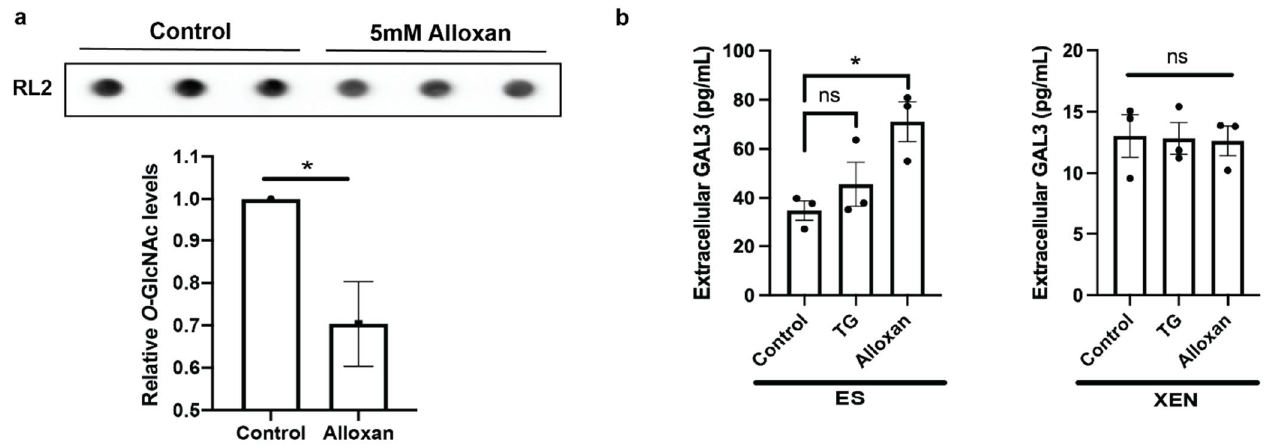
Figure 5. OGT inhibition in ES cells increases extracellular galectin-3. ( a ) Immunodot blot of O - GlcNAc detecting antibody RL2 in ES cells treated with 5 mM alloxan, an OGT inhibitor, and densitometry; ( b ) ELISA measuring secretion of galectin-3 from ES and XEN cells treated with 10 µ M TG or 5 mM alloxan for 8 days normalized to total intracellular protein (mg/mL). Bars represent mean values ± SEM, N = 3. * p < 0.05.